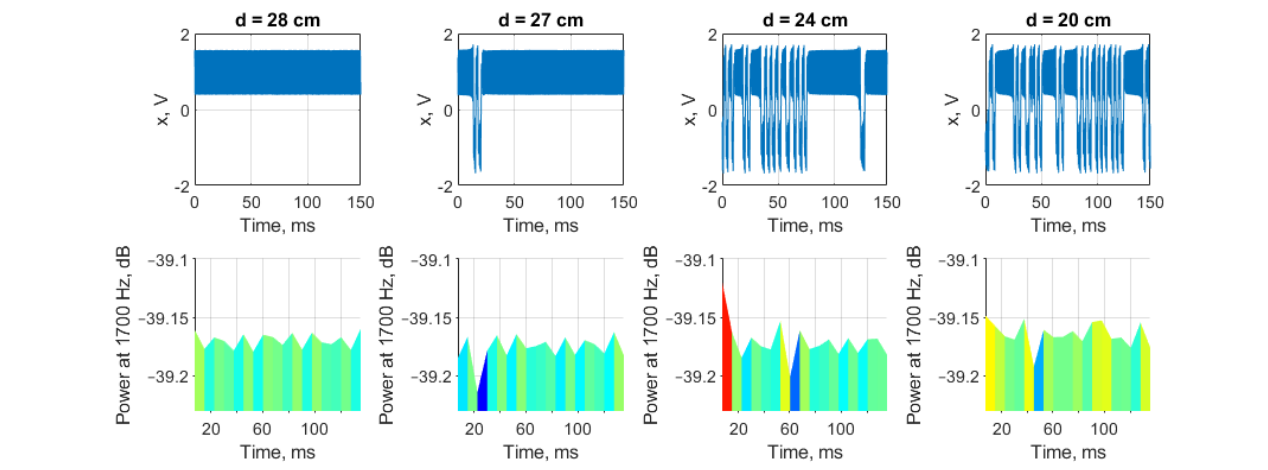
Figure 23. STFT analysis of the differential amplifier output (lower row) and corresponding Duffing oscillator time-domain output (upper row). Compared with the case d = 28 cm (target not recognized), the spectrogram at d = 20 cm clearly shows an increase in the signal energy at a harmonic oscillator driving frequency of 1700 Hz. However, at longer distances, the signal energy briefly or even imperceptibly exceeds the idle state